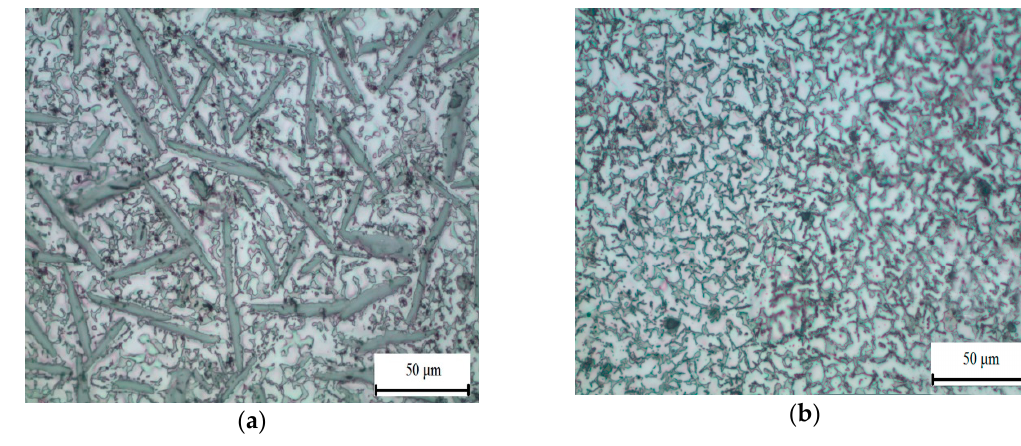
Figure 6. Primary crystals of Ca-containing phases in hyper-eutectic quaternary alloys Al10Mg10Ca2Si ( a ) and Al10Mg4Ca2Si ( b ), optical microscope (OM).